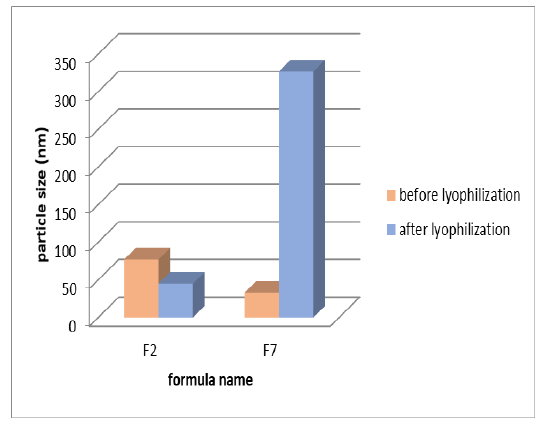
Figure 5. The particle size of the prepared